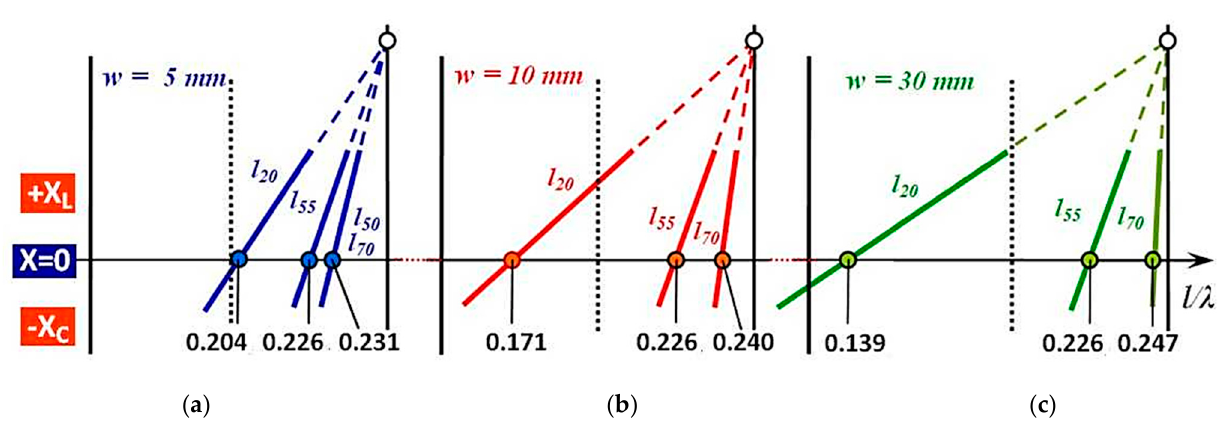
Figure 12. Change of position of resonance points l / λ res of flat microwave antennas when changing the slimness coefficient Ω : ( a ) Resonance points of very narrow antennas w = 5 mm; ( b ) Resonance points of medium-wide antennas w = 10 mm; ( c ) Resonance points of very wide antennas w = 30 mm.